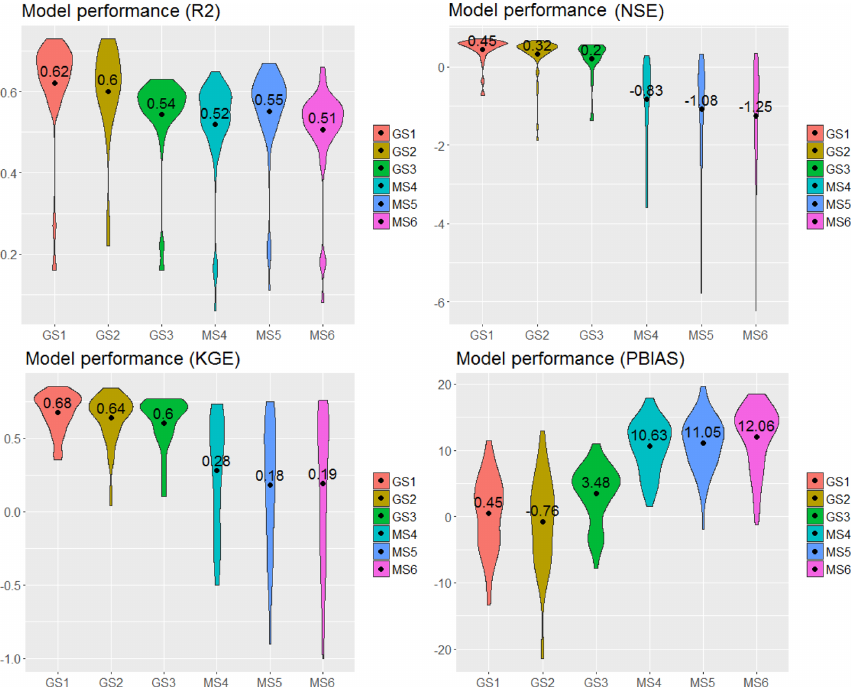
Figure 9. Plots of the performance result of SWAT in simulating actual evapotranspiration. The values and the black dot symbols ( • ) depict the average value of R 2 , NSE, KGE and PBIAS obtained for each